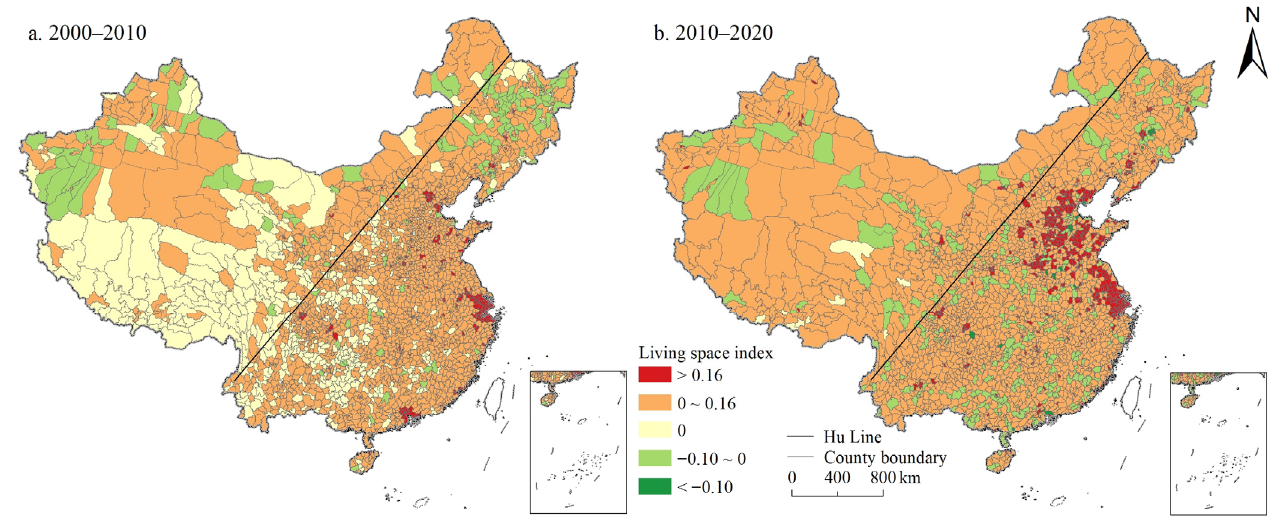
Figure 2. Spatial distribution of LSI changes in China during 2000–2020.